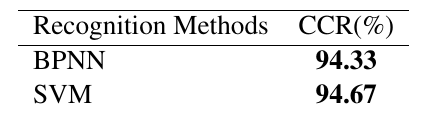
Table 2. CCRs of BPNN and SVM methods.